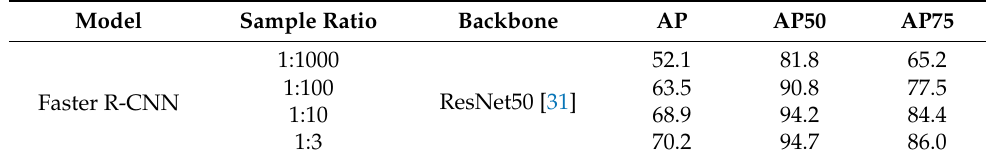
Table 1. Detection results with different sample ratios on BCTSDB.